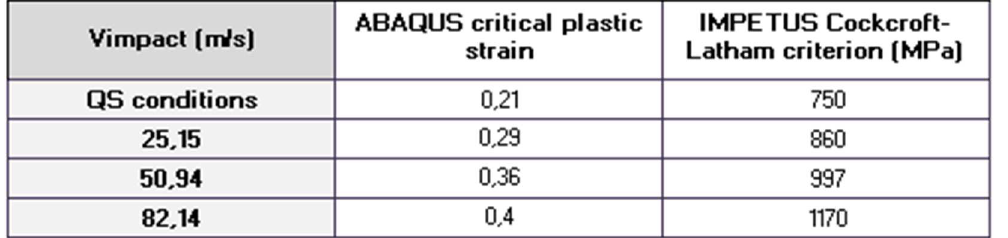
Table 1. Fitted ABAQUS and IMPETUS damage parameters for studied QS and dynamic